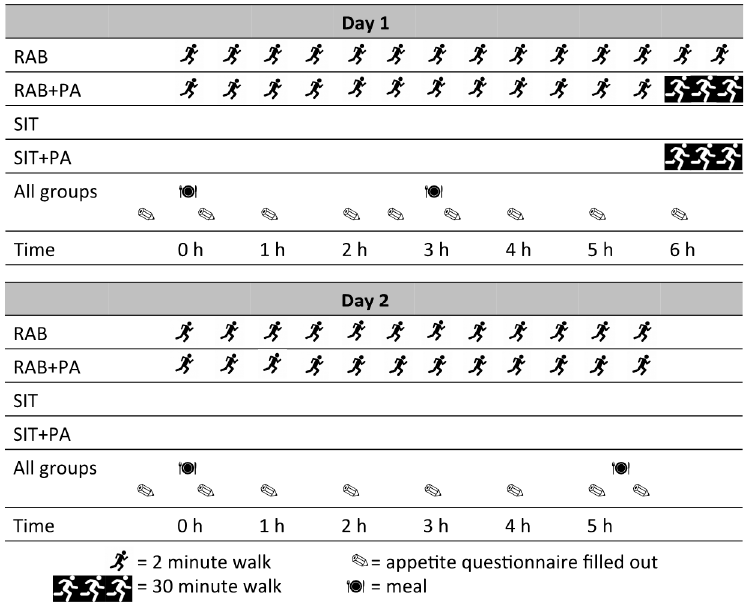
Figure 1. Timing of activities, meals, and questionnaires on Days 1 and 2 of each intervention. RAB: regular activity breaks; RAB+PA: regular activity breaks with physical activity; SIT: prolonged sitting; SIT+PA: prolonged sitting with physical activity.